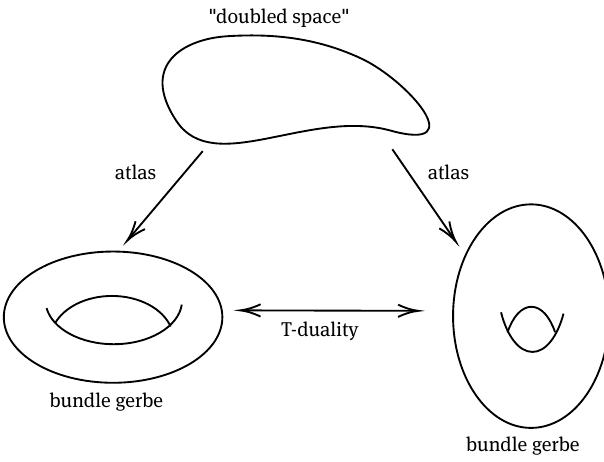
Figure 2: the "doubled space" seen as the atlas of both a bundle gerbe and its